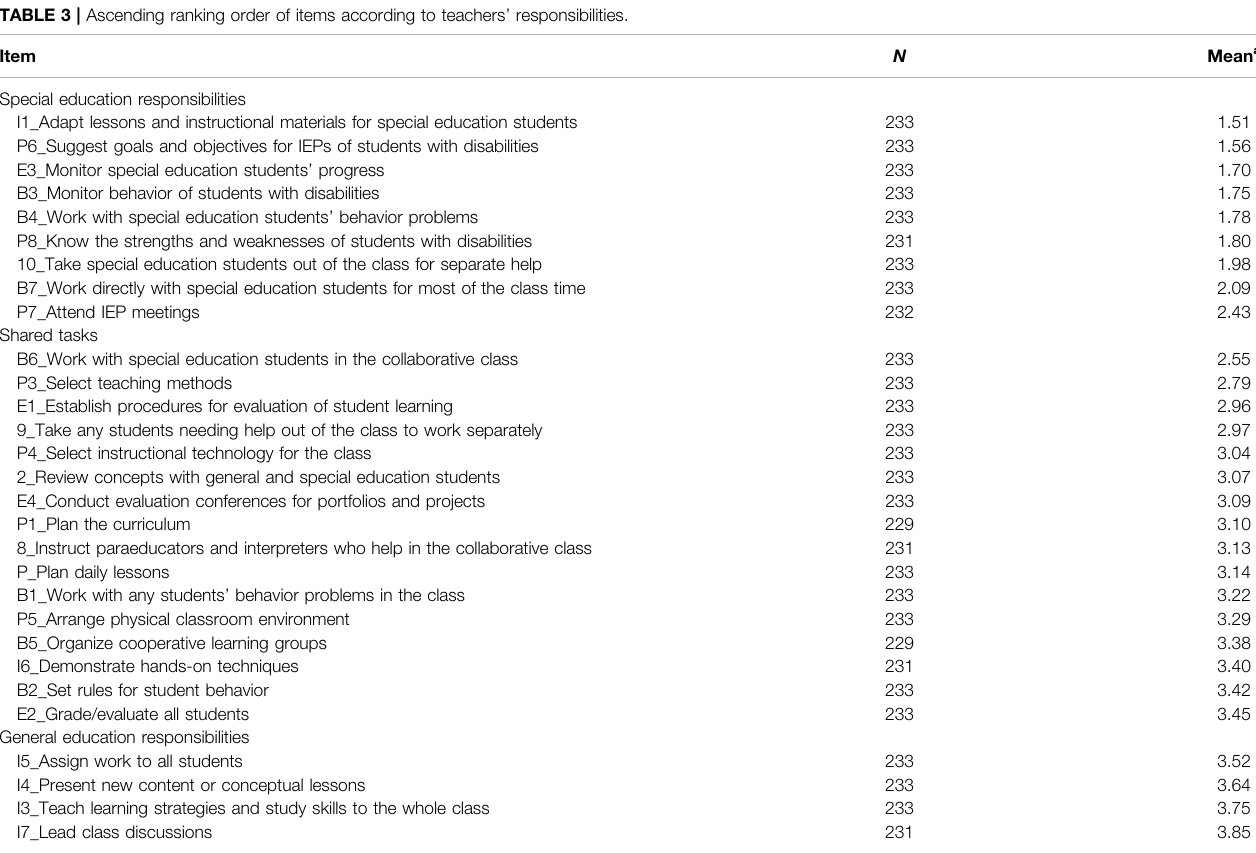
TABLE 3 | Ascending ranking order of items according to teachers ’ responsibilities.